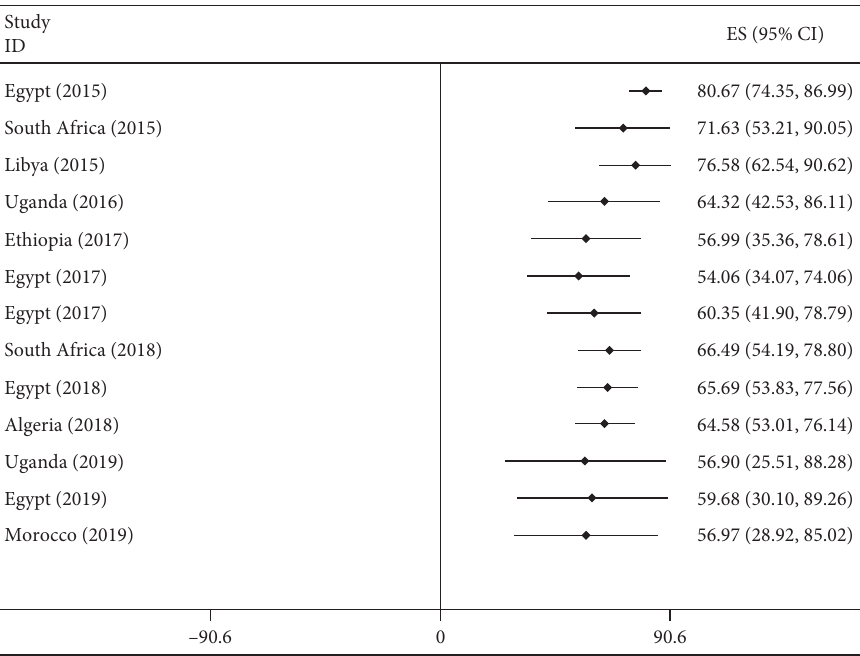
Figure 13: Cumulative meta-analysis of CPAB between 2015 and 2019 in